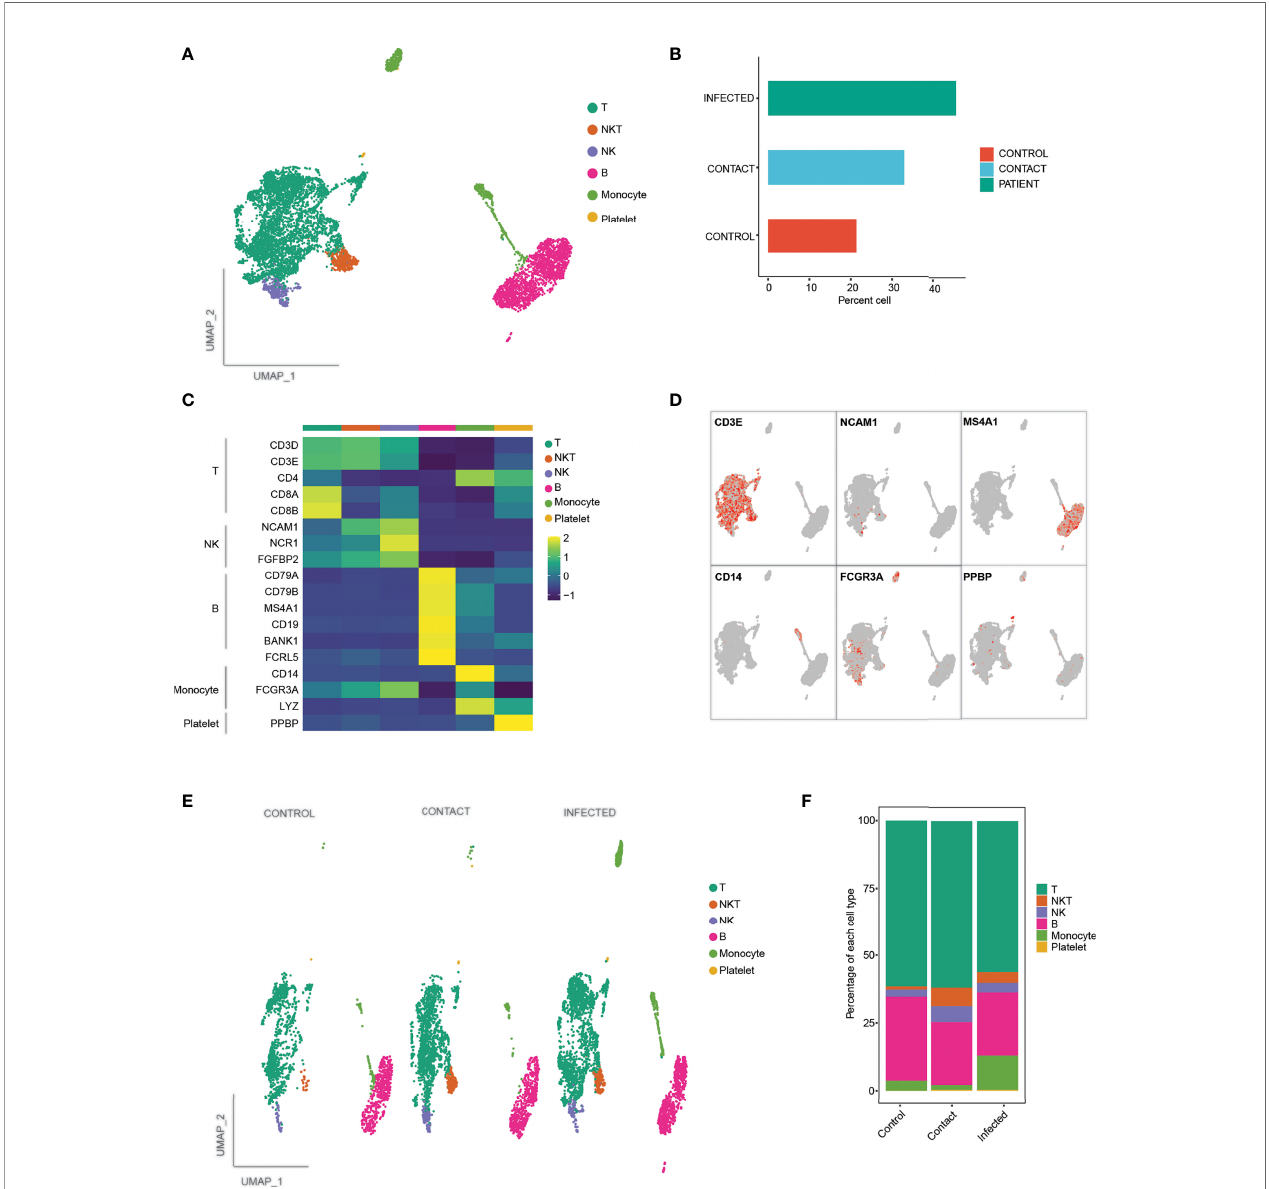
FIGURE 3 | scRNA-seq analysis and demarcation of cell types according to characteristic markers. (A) UMAP representation of 7,848 single cells, color coded according to cell type. (B) Bar plot showing the percentage of cells contributed by control, contact, and infected samples. (C) Heat map showing canonical markers for individual T, B, NK, NKT, monocytes, and platelets, respectively. (D) UMAP representation of canonical markers for T cells (CD3E), B cells (MS4A1), NK (NCAM1, FCGR3A), NKT (CD3E, NCAM1), monocytes (CD14, FCGR3A), and platelets (PPBP). (E) UMAP representation of clusters strati fi ed per individual samples: controls, contact, and patients color coded according to cell types. (F) Bar plot showing relative contribution of each of the cell types in controls, contact, and